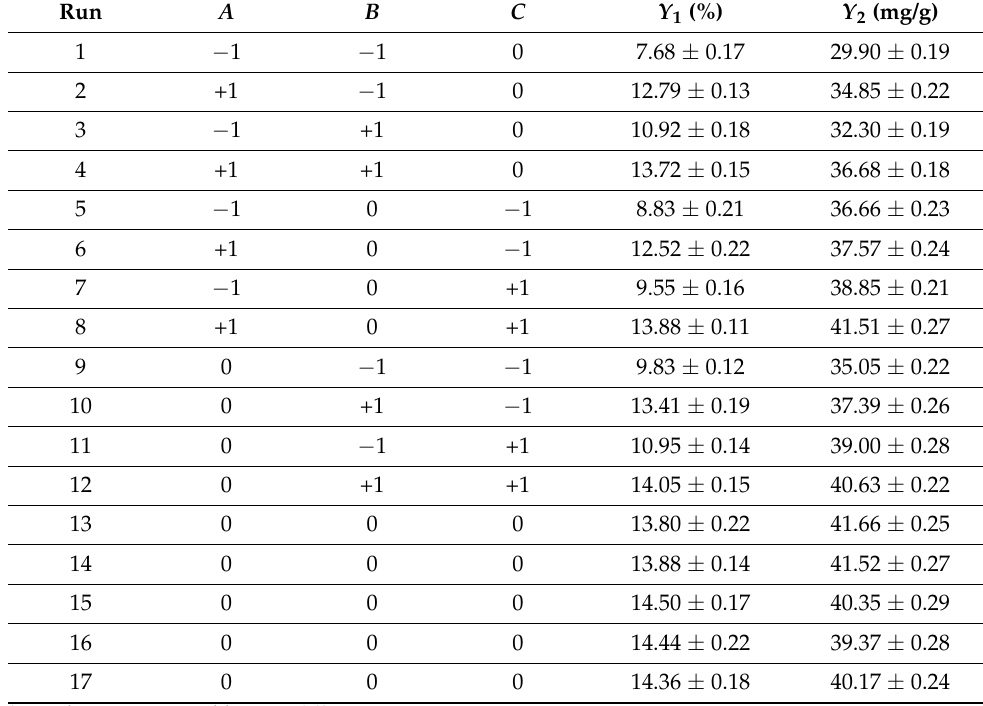
Table 2. Experimental design and response